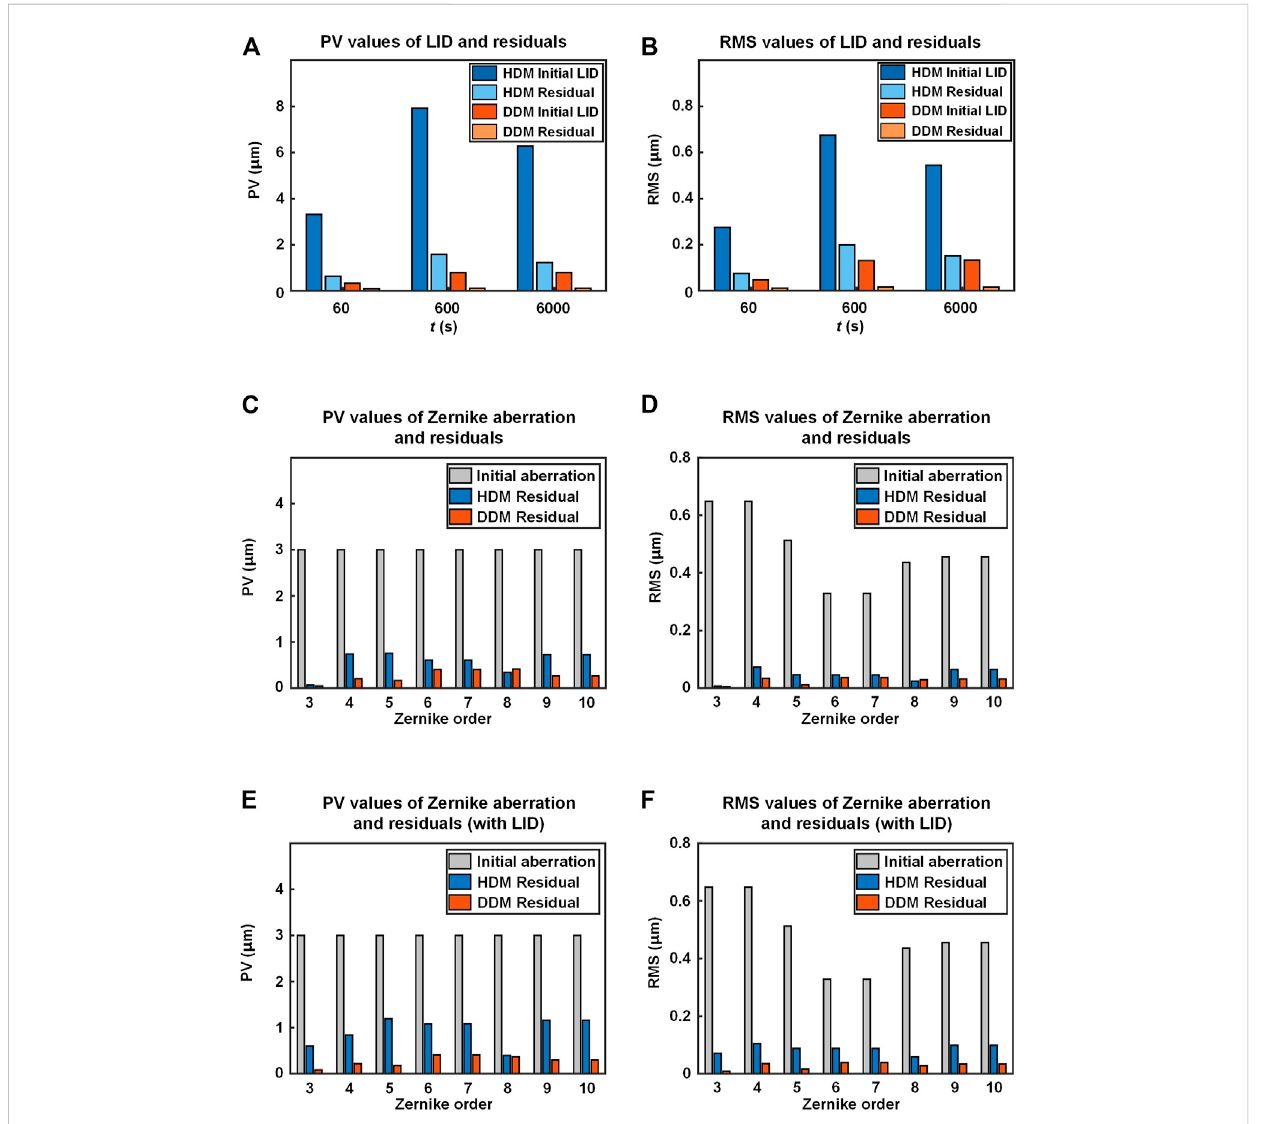
FIGURE 9 Wavefront correction performance of the HDM (blue ones) and the DDM (orange ones). (A) PV and (B) RMS values of LID and self-correction residuals. (C) PVand (D) RMSvaluesofinitialaberrationandcorrectionresidualsofZernikemodeaberrations. (E) PVand (F) RMSvaluesofinitialaberration and correction residuals of Zernike mode aberrations superimposed with